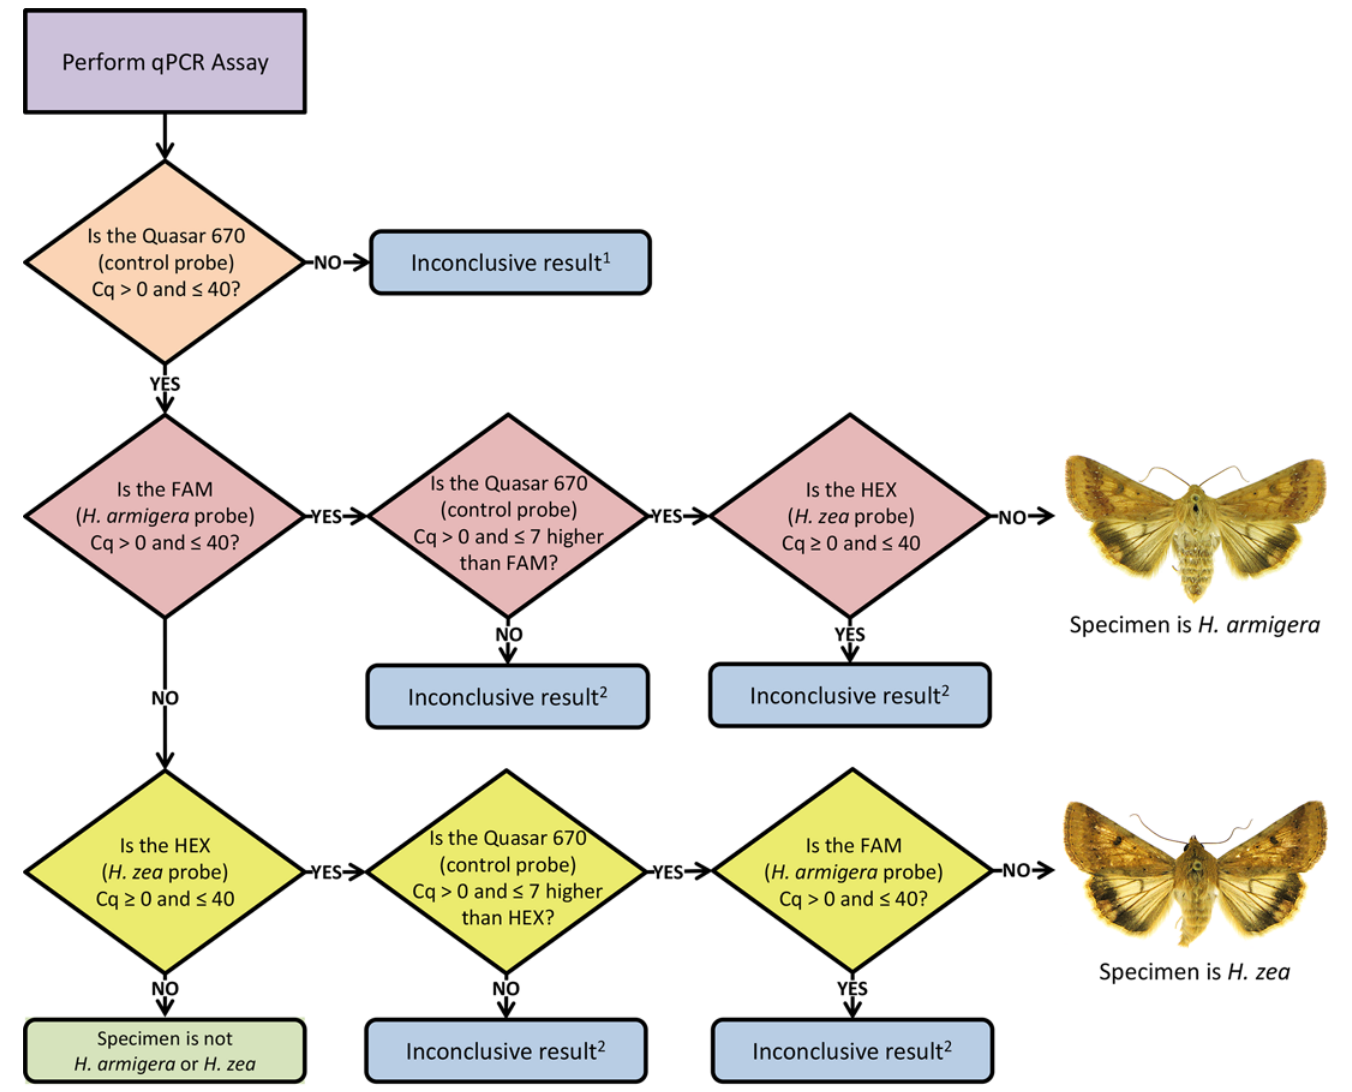
Fig 4. Decision tree flowchart developed using the interpretation rules for the triplex real-time PCR assay run on a Bio-Rad CFX96